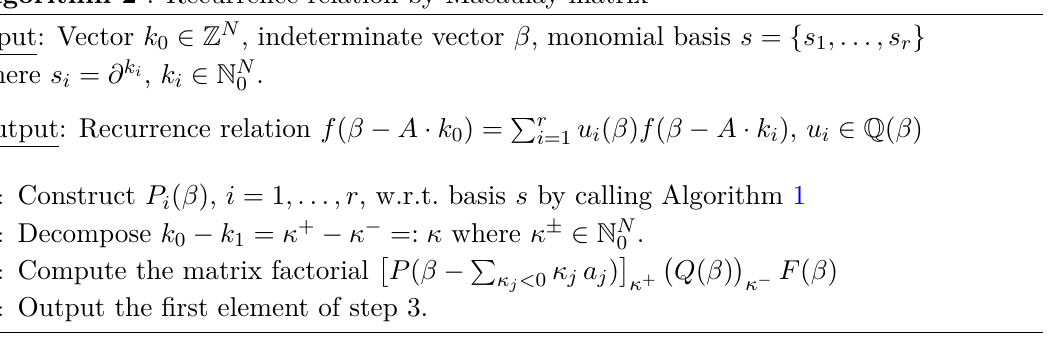
Algorithm 2 : Recurrence relation by Macaulay